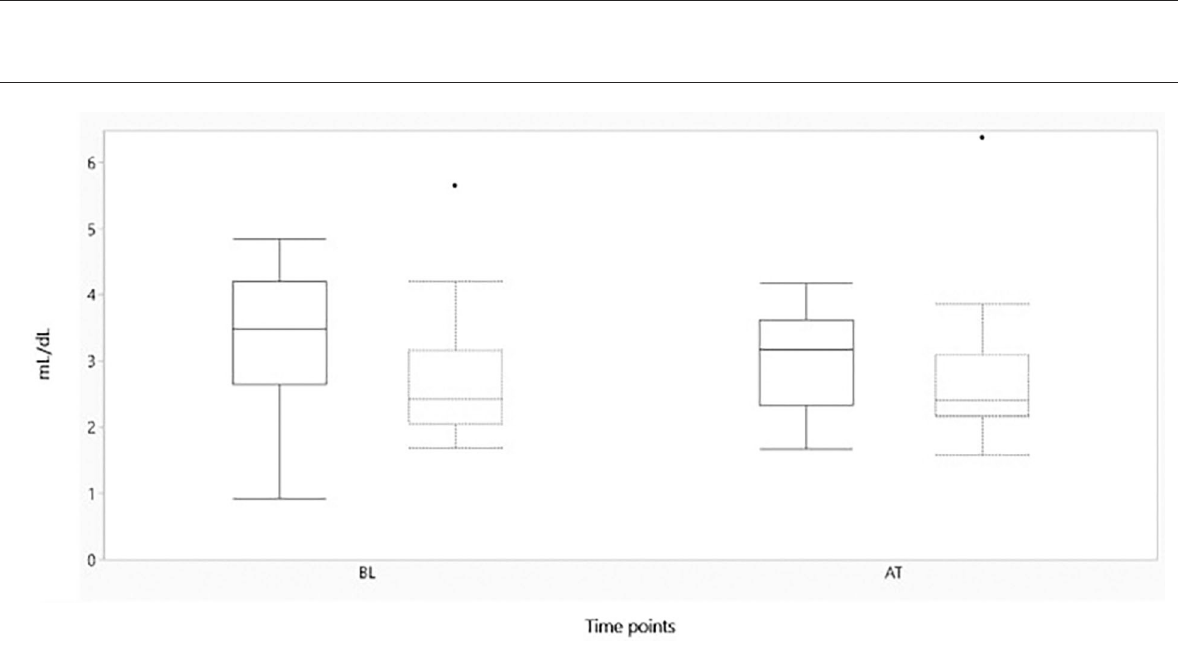
FIGURE4 Boxplot showing oxygen extraction (mL/dL) on the y-axis, before and after administration of either morphine or NaCl IV. The x-axis represents baseline and after treatment of either morphine or NaCl 0.9% IV. The solid line represents the morphine group and the staple line the placebo group. Boxplot characteristics: upper line = maximum value, excluding outliers, upper line of box = Q3 (75th percentile); middle line in box = median: lower line in box = Q1 (25th percentile) lower line = minimum value excluding outliers, dots = outliers. AT, after treatment; BL,